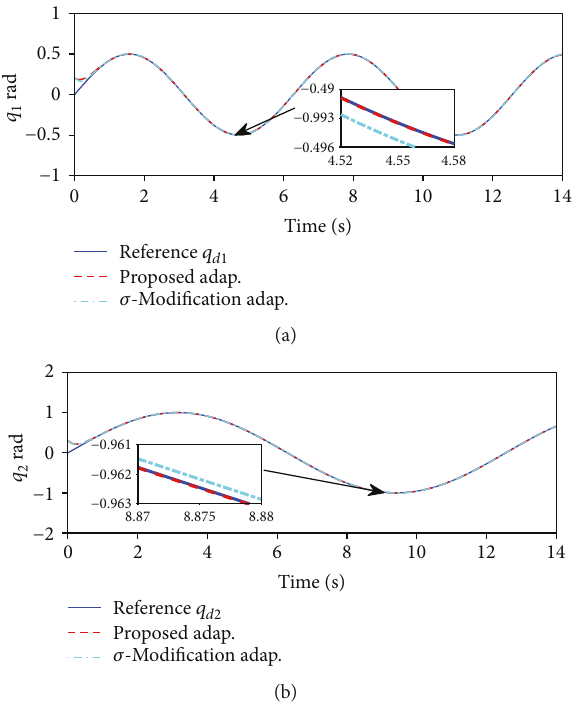
Figure 3: Tracking performance of robotic joint position q